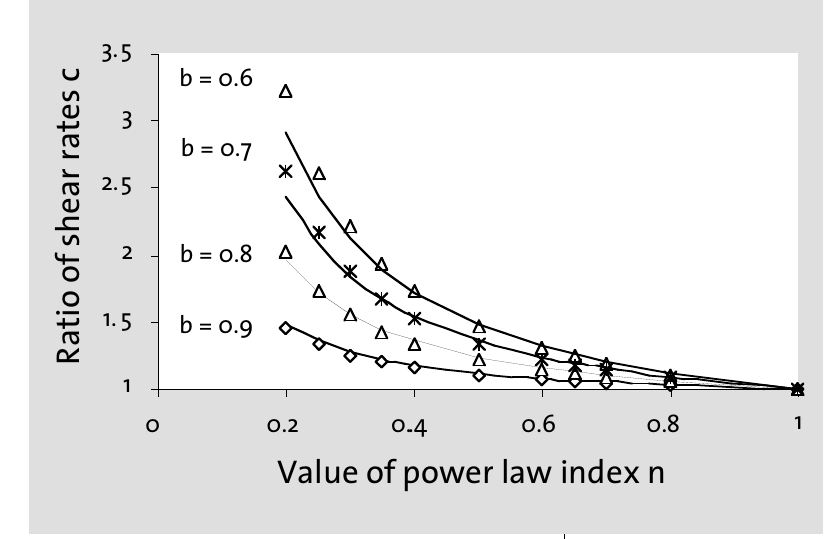
Figure 7: The shear rate at the rotating cylinder as a ratio of the Newtonian equivalent, plotted as a function of power-law index for different values of gap ratio. Also shown as solid lines is the simple formula, c = 1 + 1.2(1 - b)(1/n – 1).